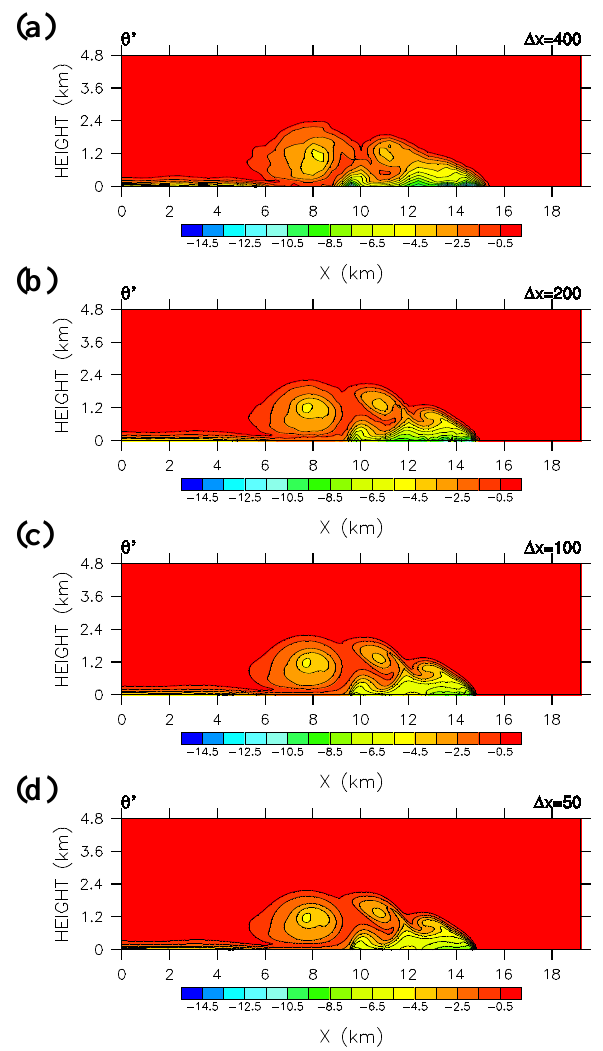
Figure 6. Potential temperature perturbation after 900s using grid FIG. 6. Potential temperature perturbation after 900 s using grid spacing of (a) 2 spacing of (a) (cid:49) ¯ x = 400m, (b) (cid:49) ¯ x = 200m, (c) (cid:49) ¯ x = 100m, and 400x ∆ = m, (b) 200x ∆ = m, (c) 100x ∆ = m, and (d) 50x ∆ = m, with 5th-order basis 3 (d) (cid:49) ¯ x = 50m, with fifth-order basis polynomials per element for polynomials per element for the density current. All simulations use 64z ∆ = m grid spacing. 4 the density current. All simulations use (cid:49) ¯ z = 64m grid spacing. The contour values are from − 14.5 to − 0.5 with an interval of The contour values are from −14.5 to −0.5 with an interval of 1.0. 5